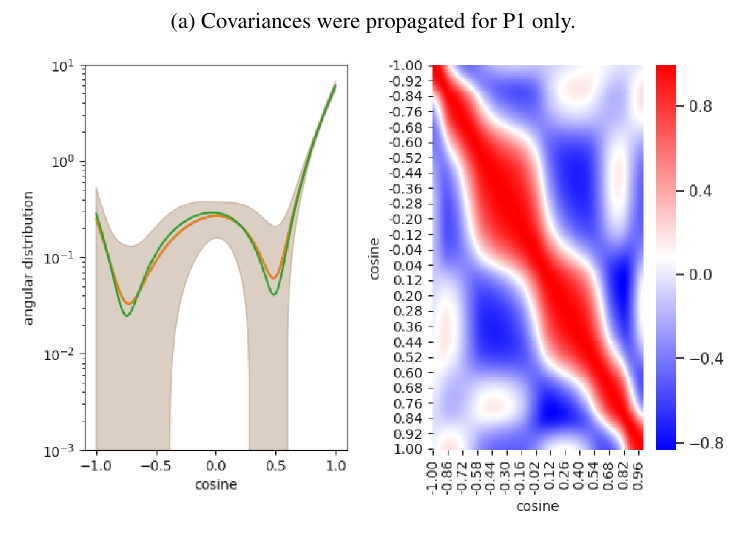
Figure 3: 238 U elastic scattering angular distibution uncertainties and correlation matrices for incident-neutron energy E in = 1 . 8 MeV. On the left, the green line represents the best estimate distribution, as derived from the evaluated file. The orange line is the average of the sampling, while the grey band is the associated standard